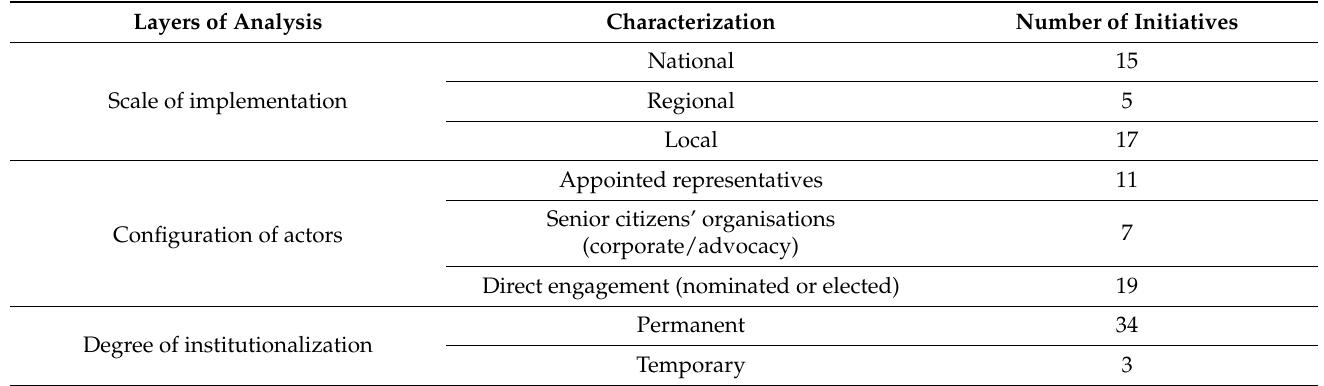
Table 4. Number of senior citizens’ participatory initiatives in policy-making, by scale of implementation, configuration of actors, and degree of